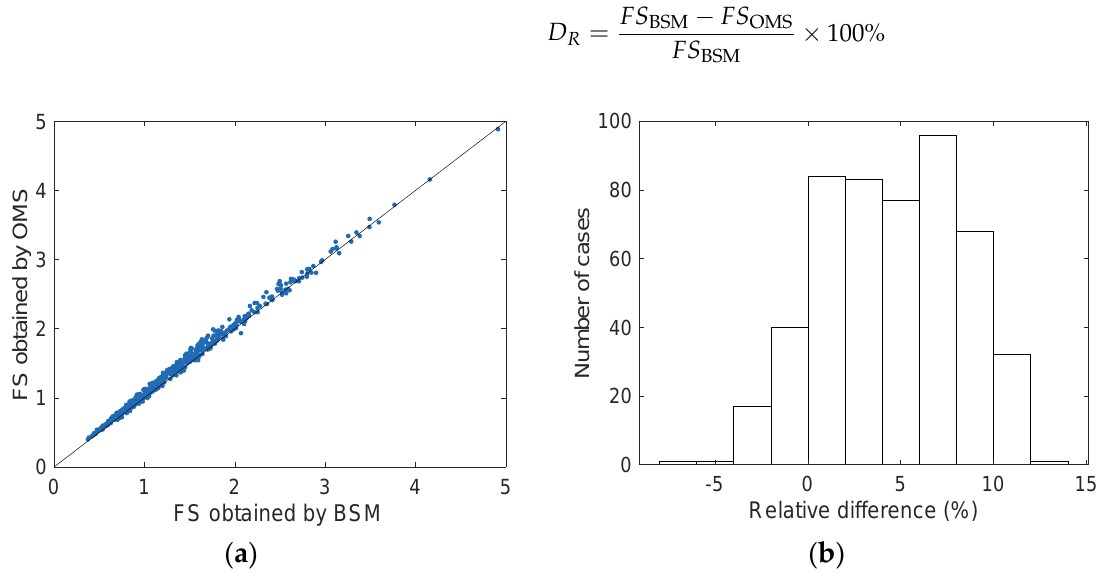
Figure 4. Evaluation of the performance of the OMS against BSM in ( a ) QQ plot of obtained FSs and ( b ) histogram of relative differences.